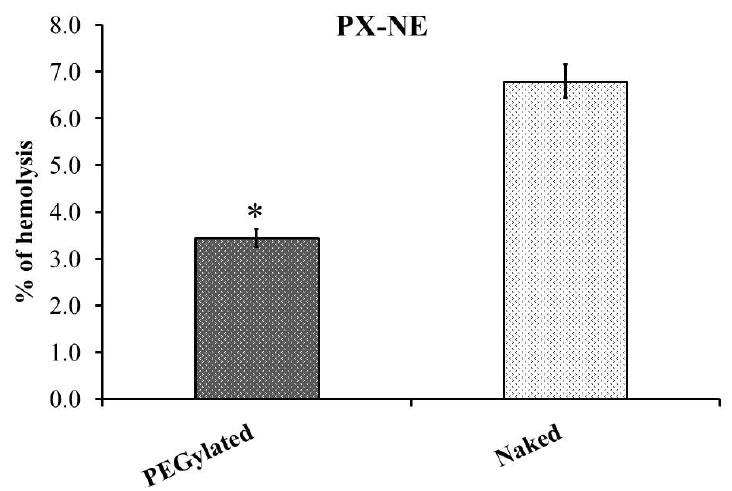
Figure 6. Hemolytic activity of PX-NE formulations after incubation with rat red blood cells (2% w/v in PBS) at 37 °C for 30 min. Results are expressed as the mean ± S.D. n = 3. * p < 0.05, compared to naked PX-NE.